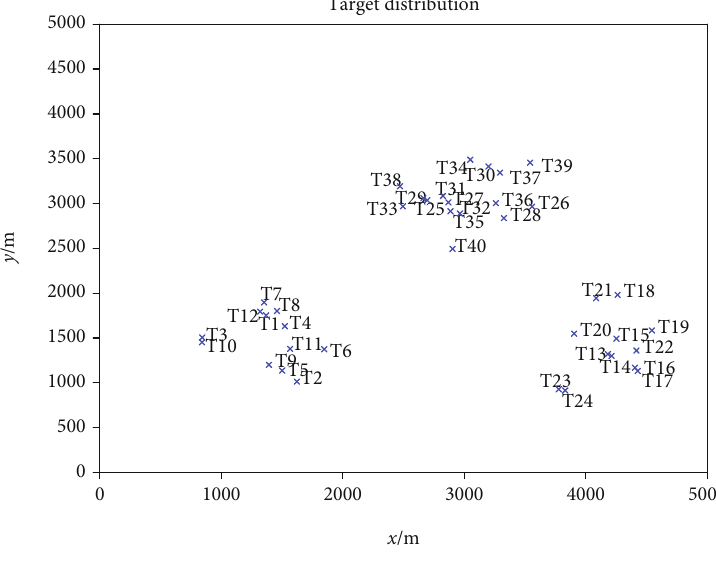
Figure 4: N T = 40 randomly distributed targets. Table 4: Relevant elements of N C = 3